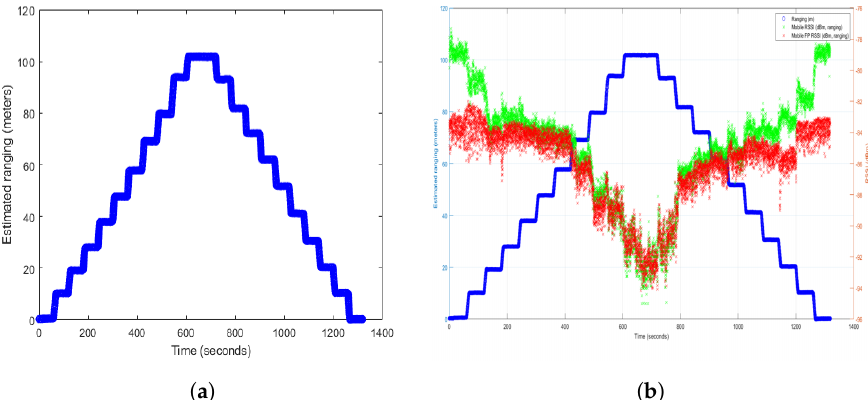
Figure 24. Estimated ranging and RSSI Test 3. ( a ) Estimated Ranging of the UWB ranging link. ( b ) Estimated ranging of the UWB ranging link and RSSI of the UWB communications link.